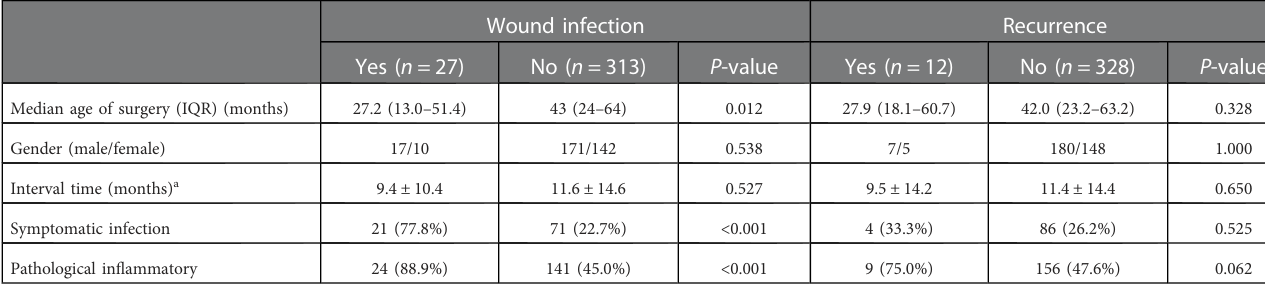
TABLE 2 Univariable analysis of postoperative wound infection and recurrence of TGDC.